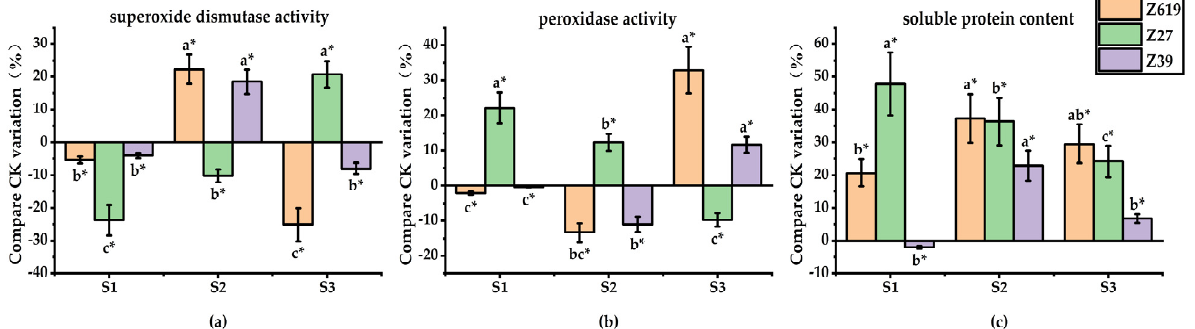
Figure 5. ( a ) Effects of different concentrations of salicylic acid on superoxide dismutase activity in root system; ( b ) Effects of different concentrations of salicylic acid on peroxidase activity in roots; ( c ) Effect of different concentrations of salicylic acid on soluble protein content in roots. * Different lowercase letters in the figure indicate that different treatments of the same variety have significant differences at p < 0.05.